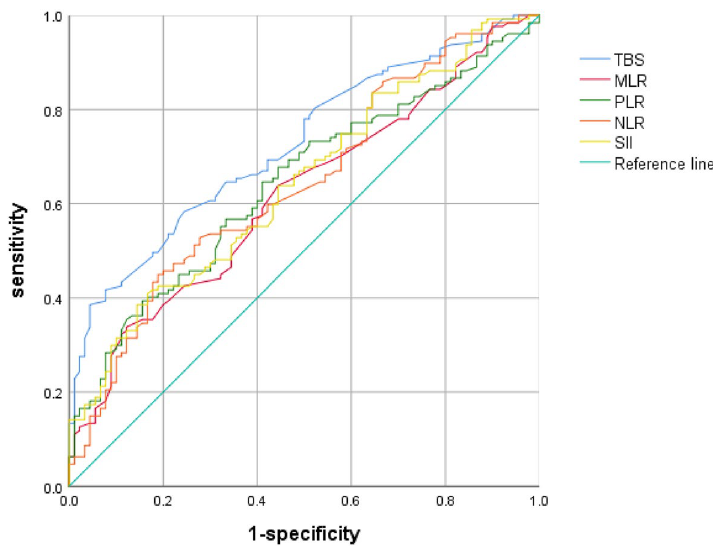
Figure 2. Comparison of the infammatory index and TBS in predicting